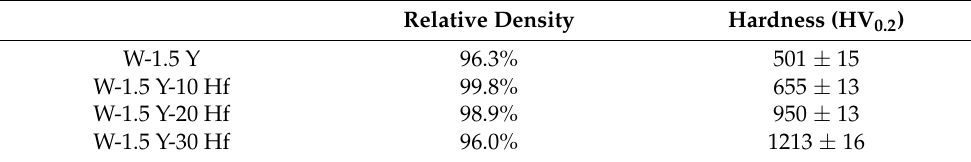
Table 3. Relative density and hardness of the W-1.5 Y alloys with the addition of different Hf contents. Relative